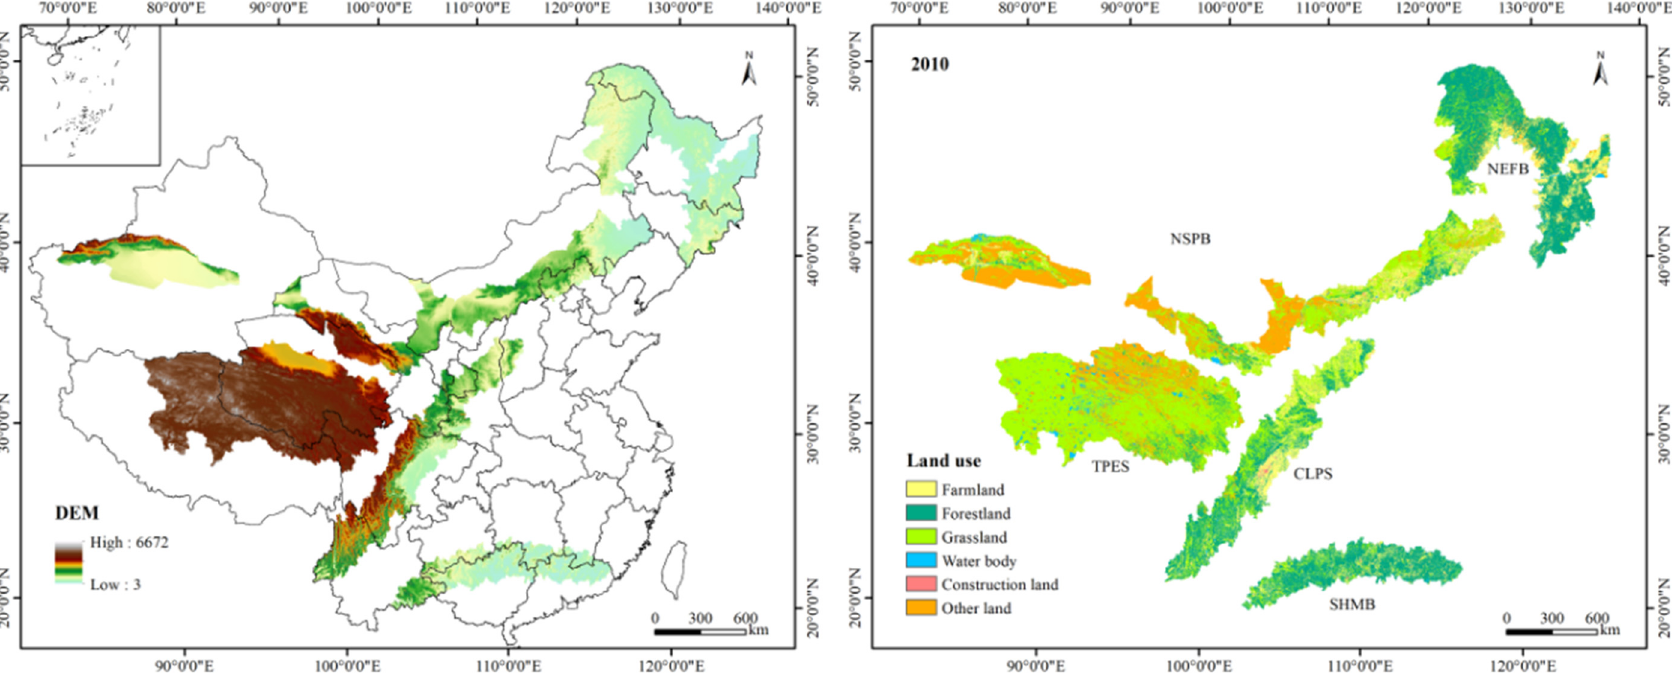
Figure 1. Geographical overview and spatial distribution of digital elevation model (DEM) and land use types of the two ecological shelters and three belts (TSTB).